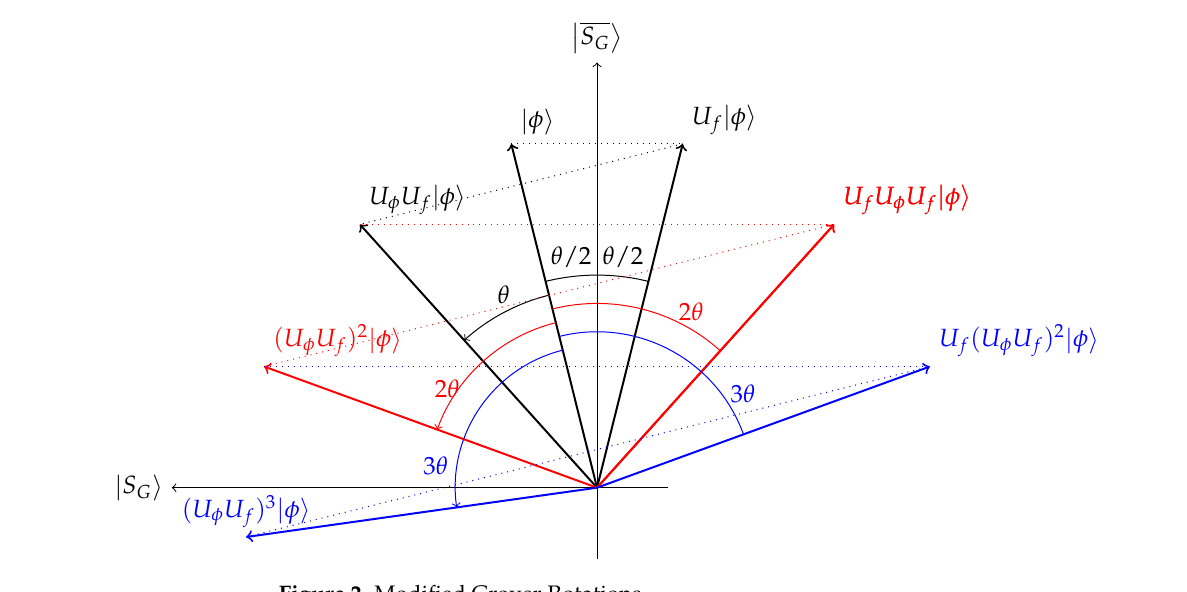
Figure 2. Modified Grover